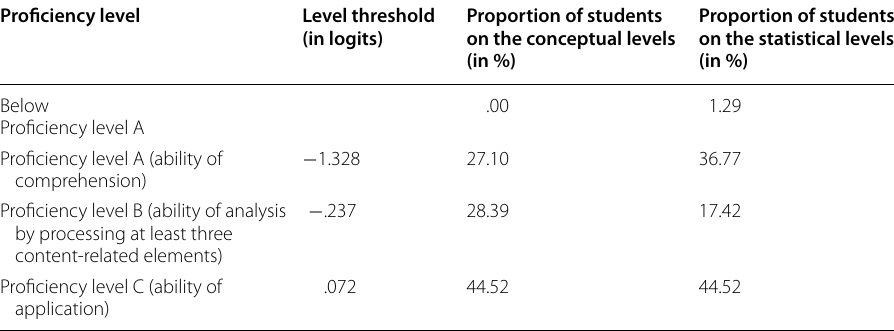
155) to the proficiency levels =